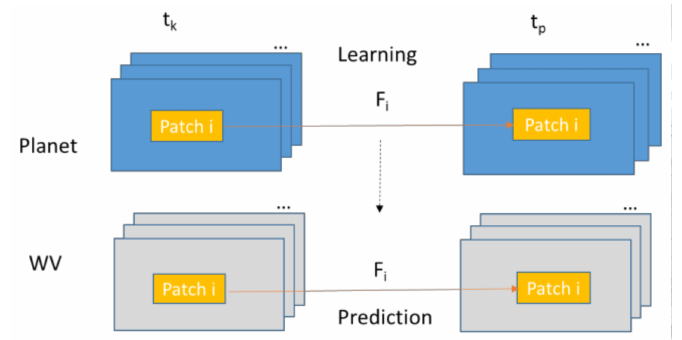
Figure 4. Proposed prediction approach based on local